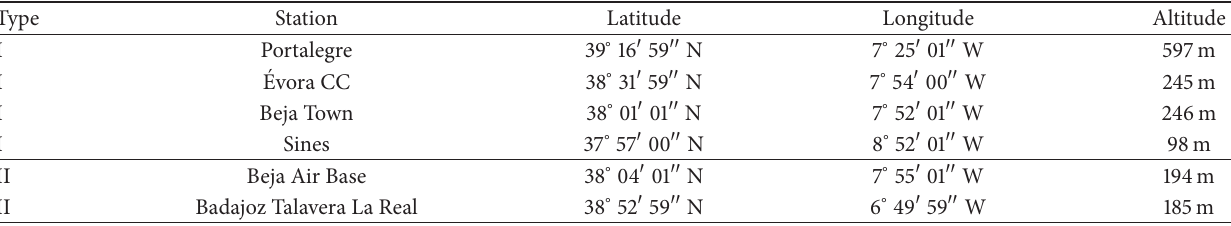
Table 1: Weather stations used.